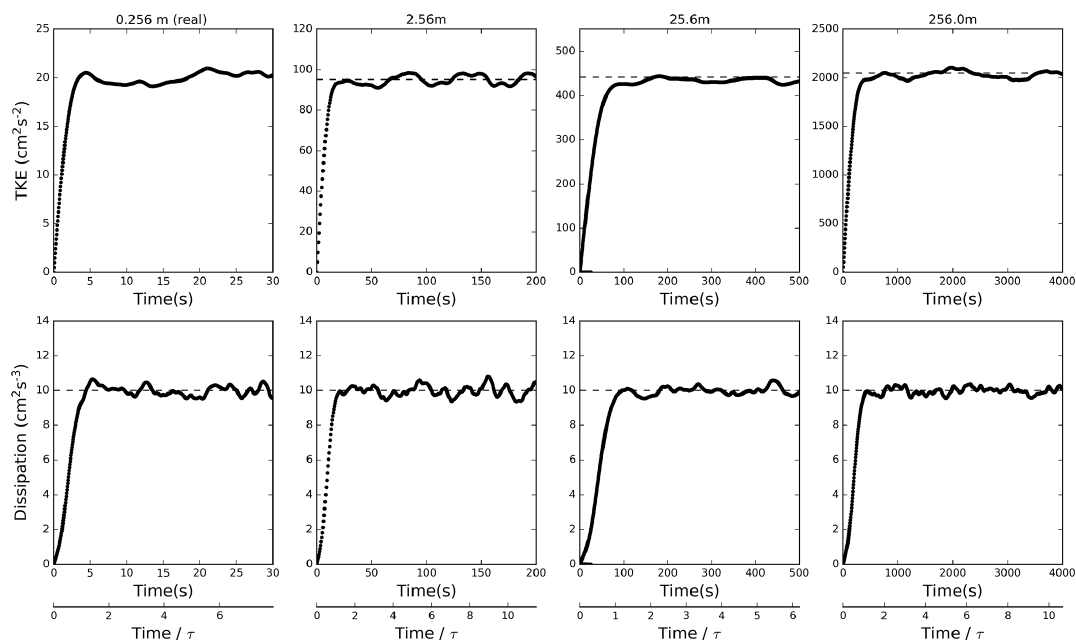
Figure 2. Evolution of TKE (upper panels) and TKE dissipation rate (lower panels) for four simulations mentioned in the text. The dashed lines are theoretical values. Bottom panels show nondimensional time using eddy turnover time; see Eq. (13) in Sect. 5.